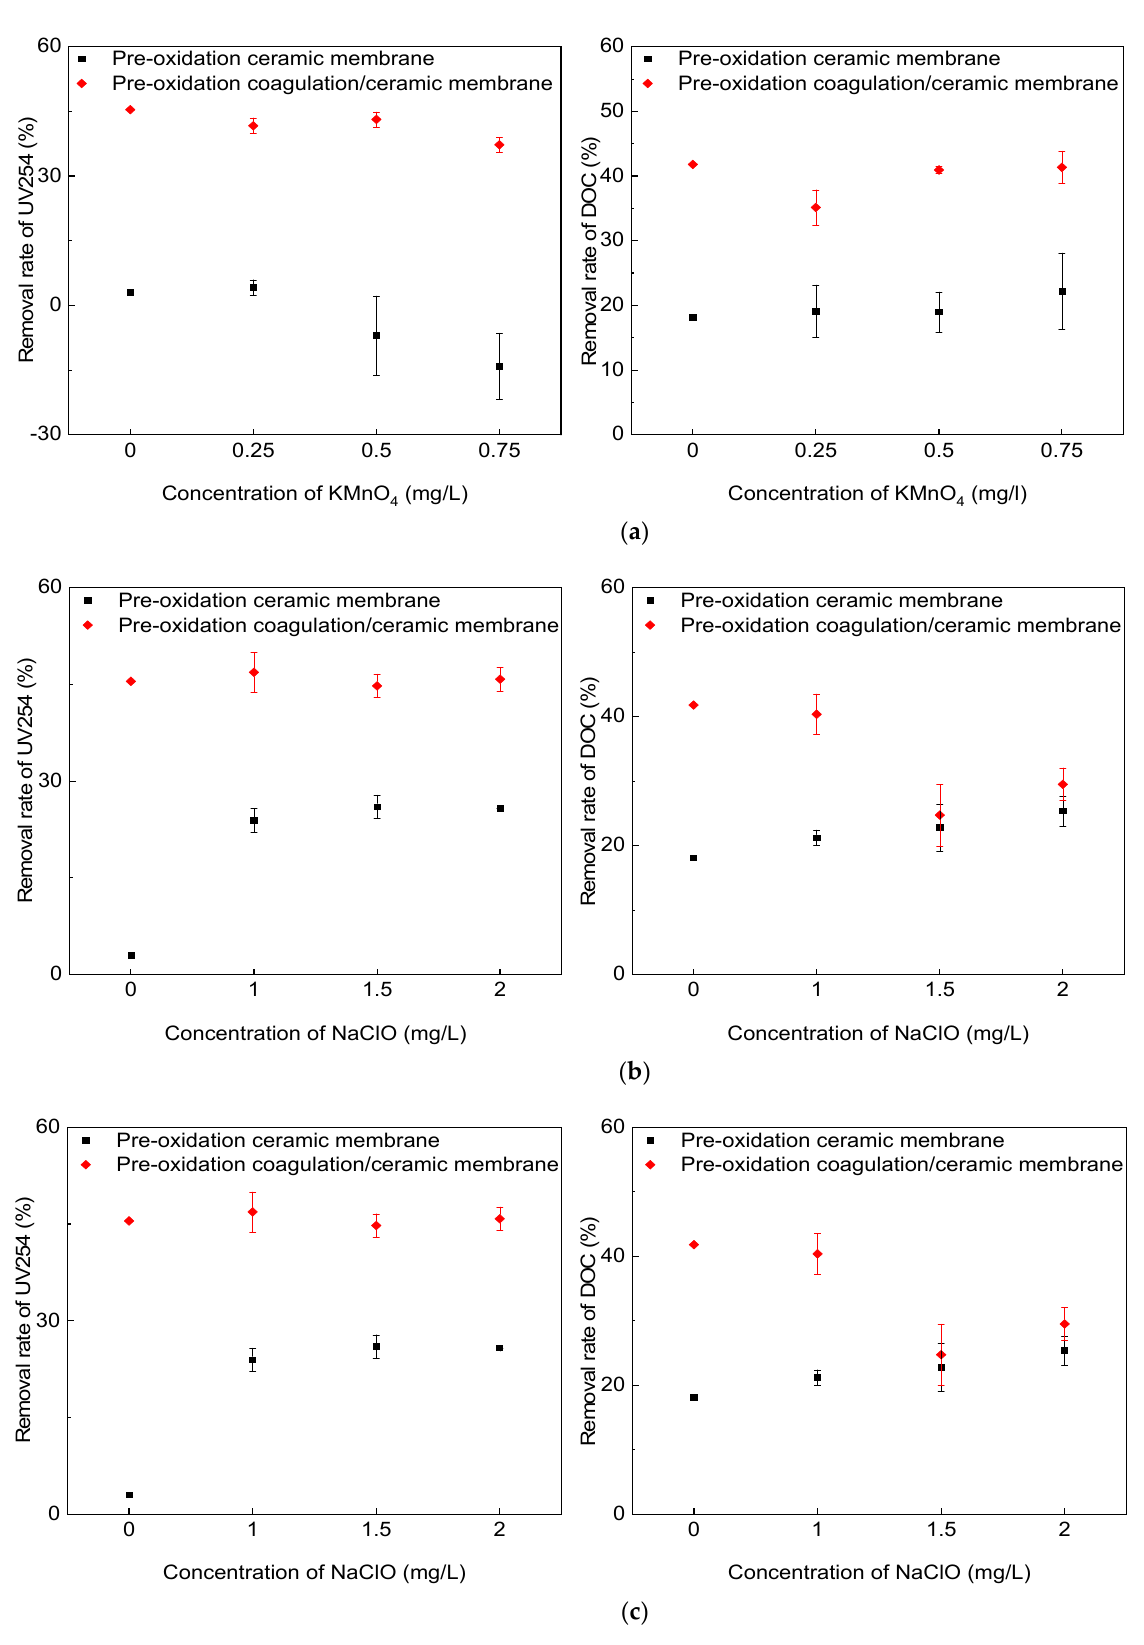
Figure 4. Effect of pre-oxidation on the removal rate of UV 254 and DOC: ( a ) KMnO 4 ; ( b ) NaClO; ( c ) O 3 .